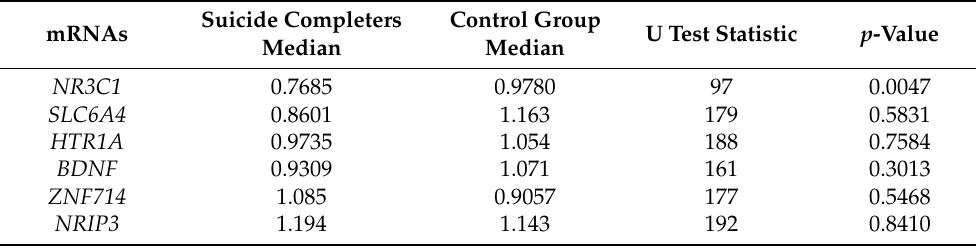
Table 5. Relative gene expression of target gene mRNAs between suicide completers and control group subjects, determined using the Mann–Whitney U test.